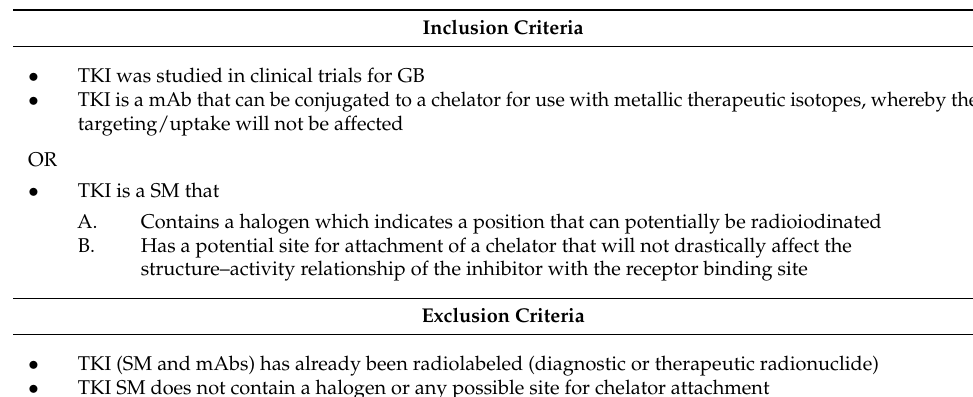
Table 10. Selection criteria for potential novel TRT of GB.